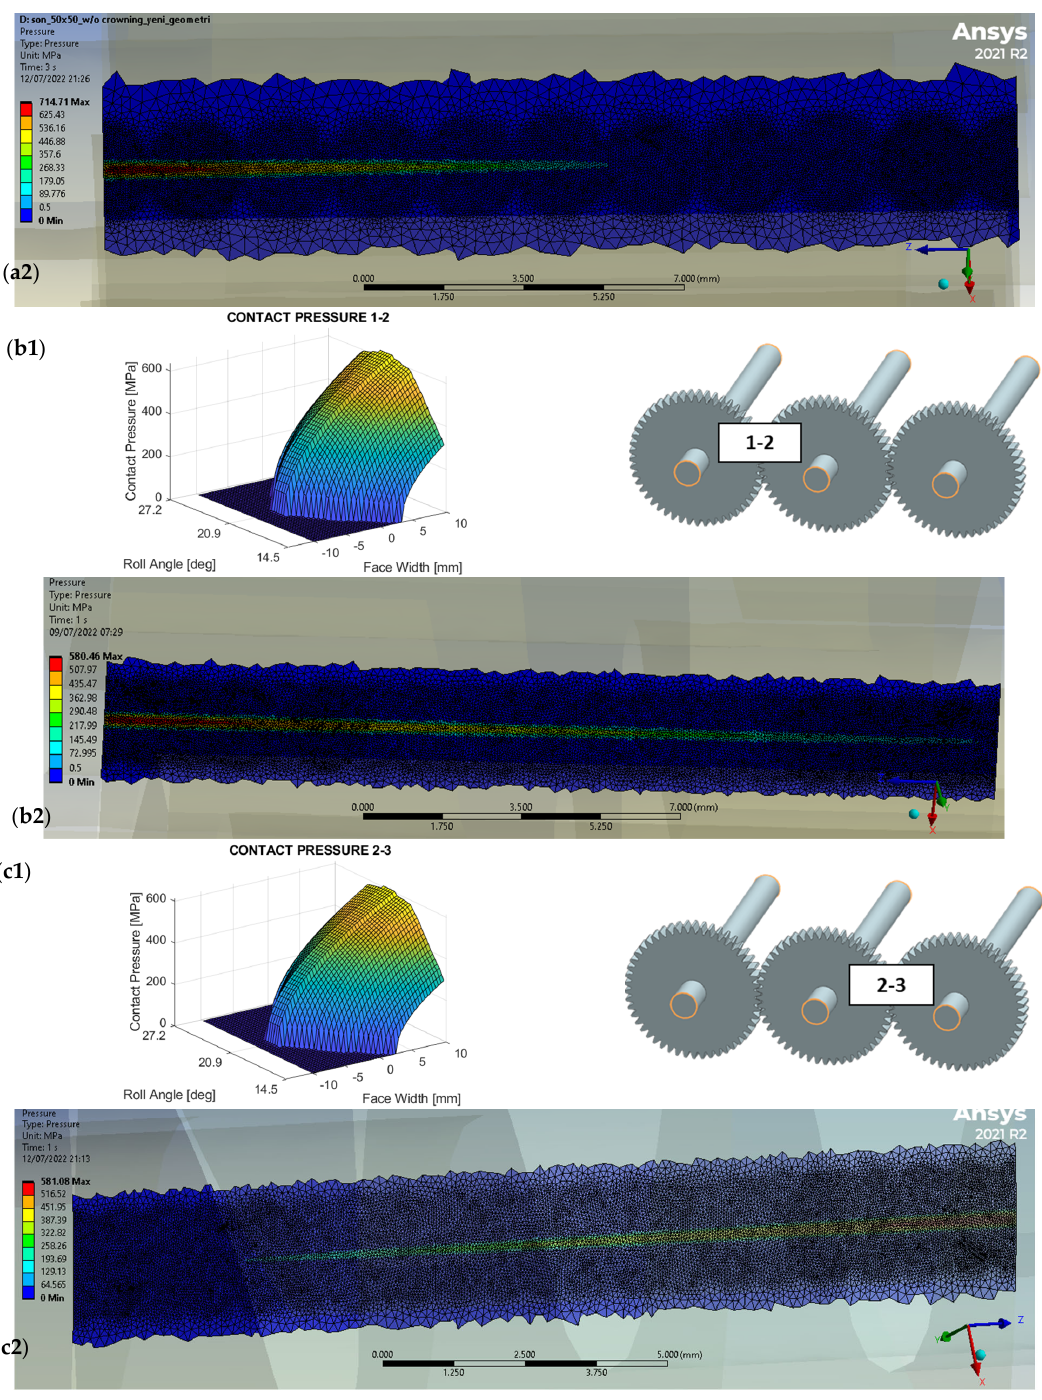
Figure 14. The proposed analytical method comparison with finite element model ( a ) Gear pair. The maximum pressure is 714 [MPa] in the torque split analytical model and 720 [MPa] in the finite element model as shown in Figure 14a. In the torque split model, the results at different gear position angles are studied using the analytical approach given